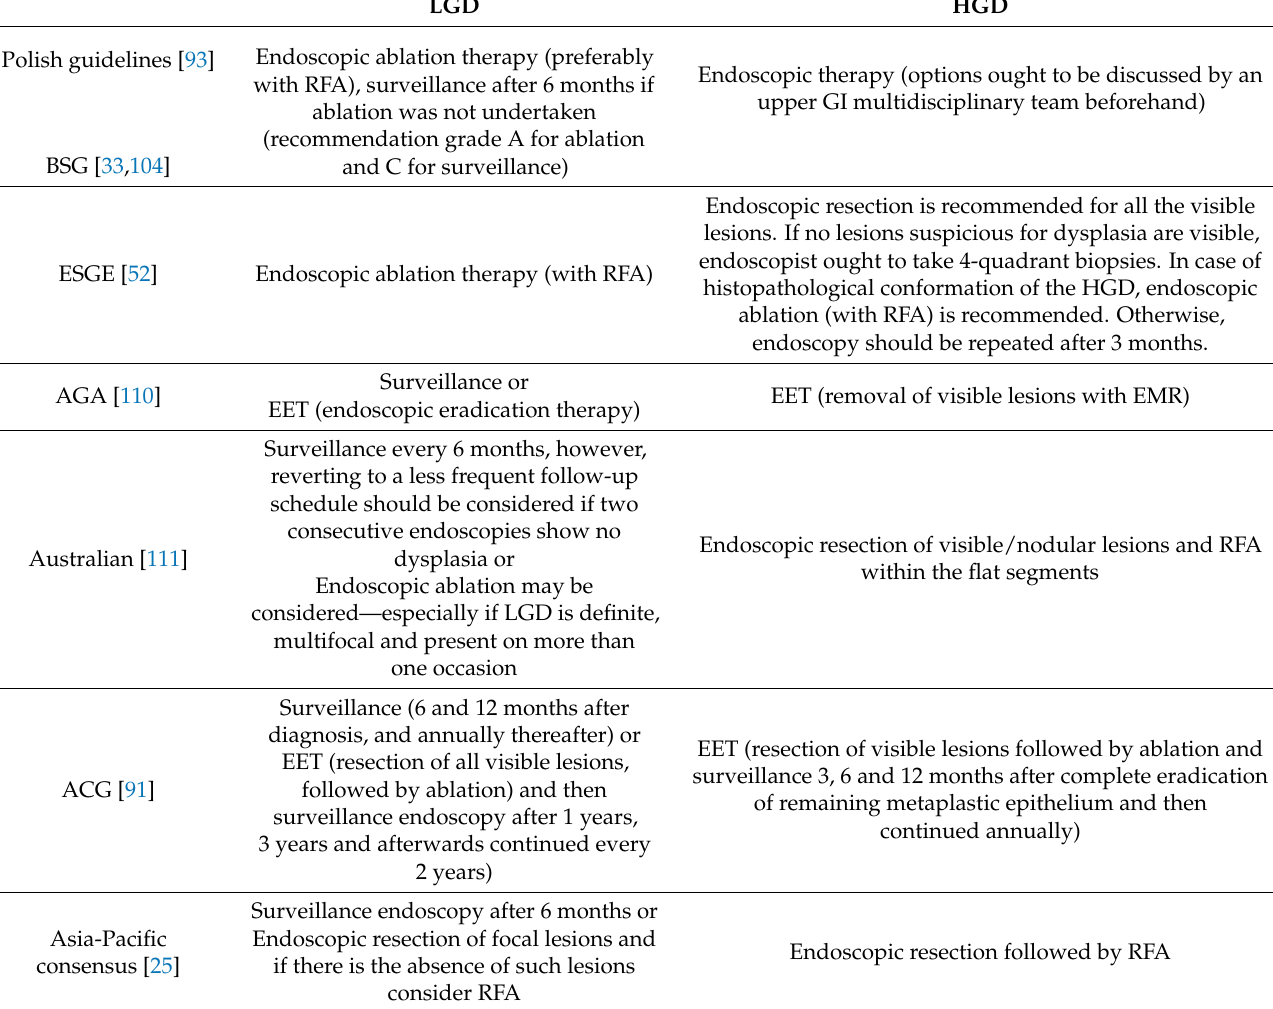
Table 3. Recommended management of LGD and